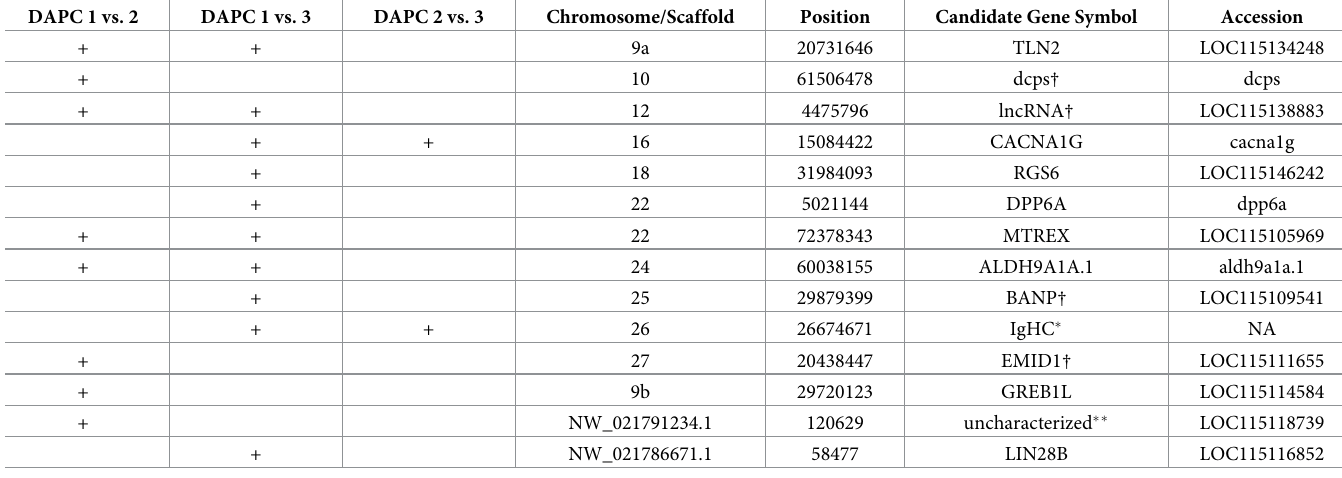
Table 1. Summary of significant eigenGWAS underlying population structure. DAPC 1 vs. 2